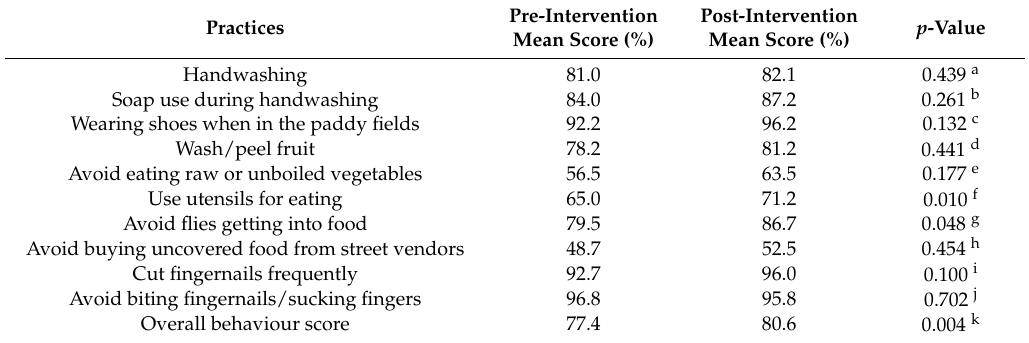
Table 2. Behaviour scores (as % of maximum number of points) pre- and post-intervention.